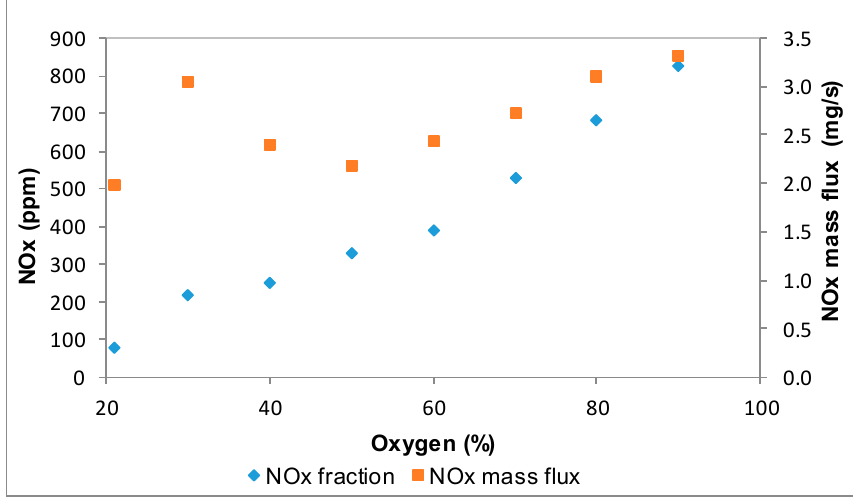
Figure 12. NO x emissions for different conditions of oxygen enrichment.